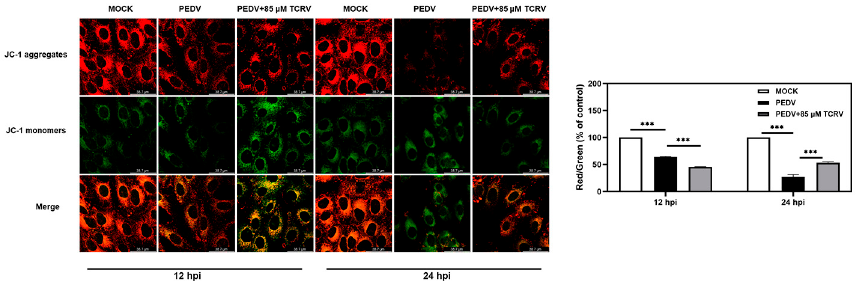
Figure 5. Effects of TCRV on mitochondrial membrane potential. ( A ) The mitochondrial membrane potential of PEDV-infected Vero cells treated with the indicated concentrations of TCRV at 12 hpi and 24 hpi. The fluorescence signals were visualized using confocal immunofluorescence microscopy. Results were presented as the ratio of JC-1 aggregate (red) to JC-1 monomer (green). Data from three independent experiments and error bars are presented as the mean ± SEM. *** p < 0.001.